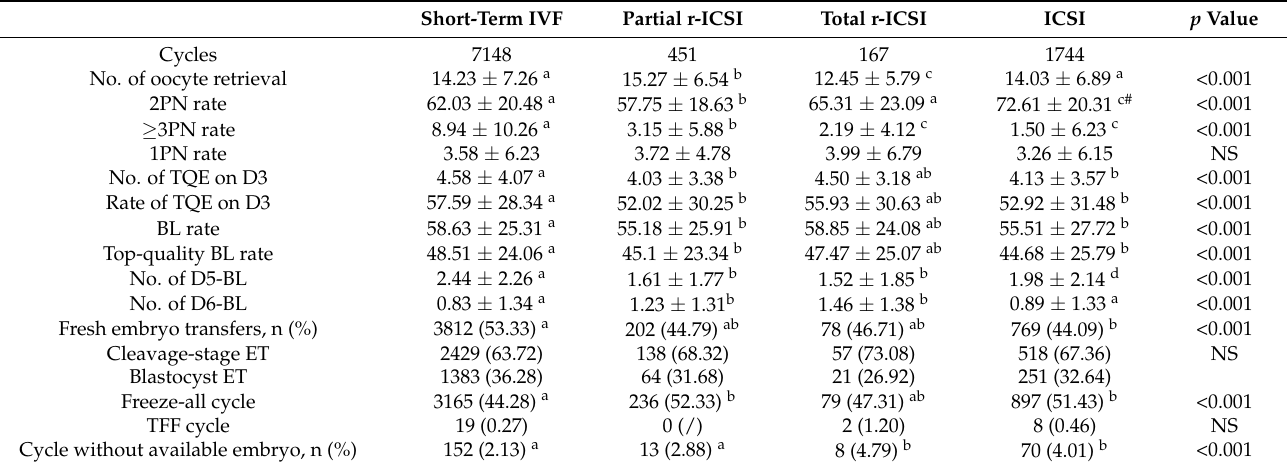
Table 2. Embryonic laboratory outcomes among four groups.